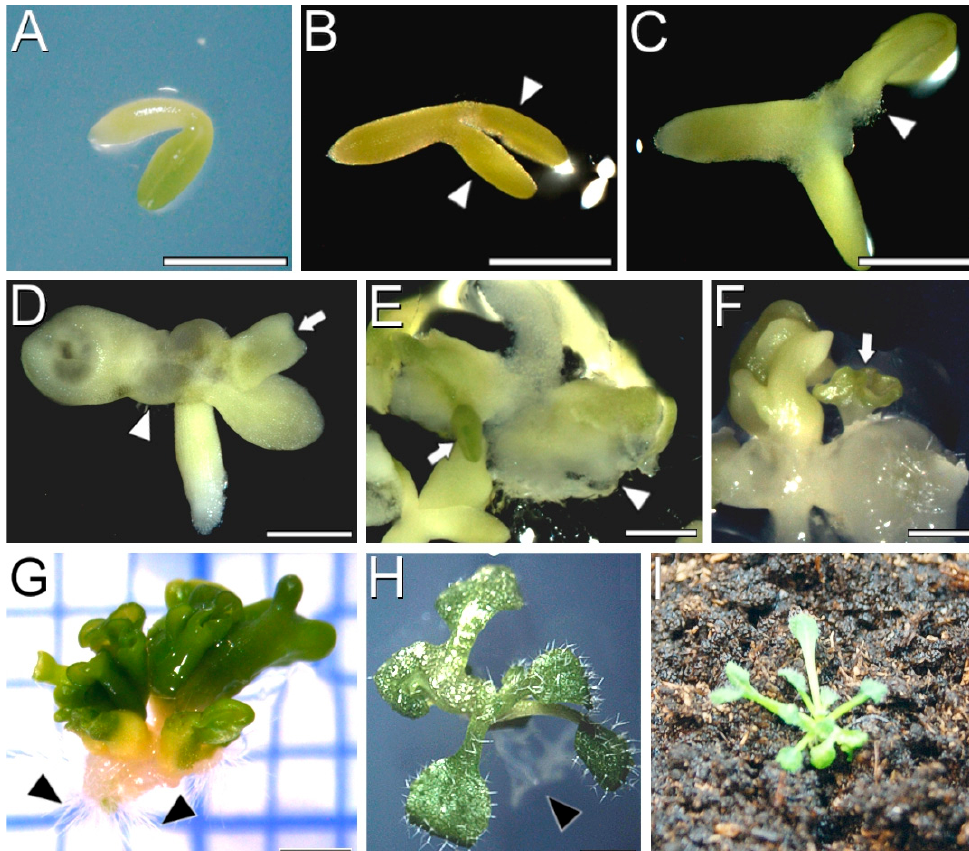
Figure 1. Induction of somatic embryogenesis from YC3.6-Bar cameleon Arabidopsis IZEs. ( A ) Freshly isolated immature cotyledonary embryo. ( B ) Four-day-old cultured IZE with thickened cotyledons (white arrowheads). ( C ) Formation of protrusions (white arrowhead) in the adaxial side of cotyledons. ( D ) Formation of a protrusion (white arrowhead) in the adaxial side of the left cotyledon, and early emergence of a somatic embryo from the adaxial side of the right cotyledon (arrow). ( E ) Development of a callus mass from a cotyledonary protrusion (white arrowhead) and of a direct somatic embryo (arrow). ( F ) Somatic embryos (arrow) developed from a callus mass derived from a protrusion after 14 days of culture. ( G ) Cluster of somatic embryos excised from the explant after 21 days of culture. Black arrowheads point to the radicles formed at the basal pole of the cluster. ( H ) Germinated in vitro plantlet from an individualized somatic embryo. Black arrowhead points to roots. ( I ) Arabidopsis plant transferred to soil and acclimatized. Bars: ( A – F ) 500 µm; ( G , H ) 1 mm; ( I ) 5 mm.